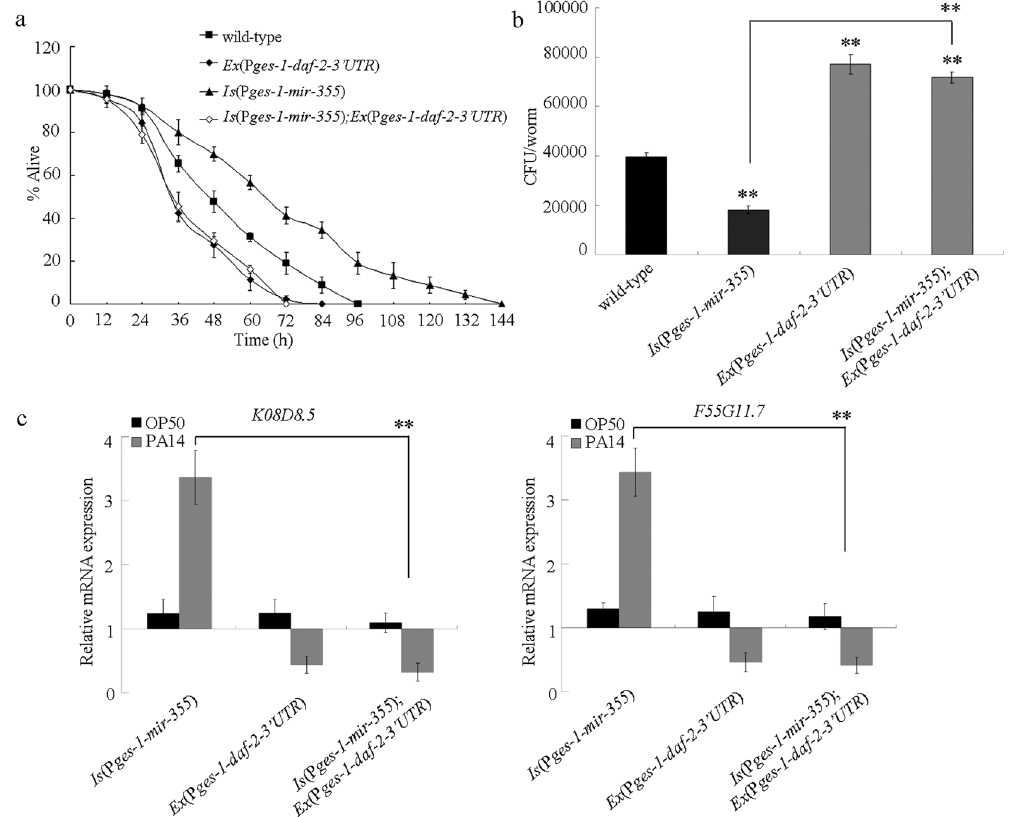
Figure 5. Effects of intestinal overexpression of daf-2 lacking 3 ′ UTR on innate immune response to P. aeruginosa PA14 infection in nematodes overexpressing intestinal mir-355 . ( a ) Effects of intestinal overexpression of daf-2 lacking 3 ′ UTR on survival of nematodes overexpressing intestinal mir-355 after P. aeruginosa PA14 infection. Statistical comparisons of the survival plots indicate that, after the P. aeruginosa PA14 infection, the survival of transgenic strain Is( P ges-1-mir-355);Ex( P ges-1-daf-2-3 ′ UTR) was significantly different from that of transgenic strain Is( P ges-1-mir-355) ( P < 0.001). Bars represent mean ± SD. ( b ) Effects of intestinal overexpression of daf-2 lacking 3 ′ UTR on P. aeruginosa PA14 CFU in the body of nematodes overexpressing intestinal mir-355 . Bars represent mean ± SD. ** P < 0.01 vs wild-type (if not specially indicated). ( c ) Effects of intestinal overexpression of daf-2 lacking 3 ′ UTR on expression patterns of putative antimicrobial genes of nematodes overexpressing intestinal mir-355 after P. aeruginosa PA14 infection. Normalized expression is presented relative to wild-type expression. Bars represent mean ± SD. ** P <